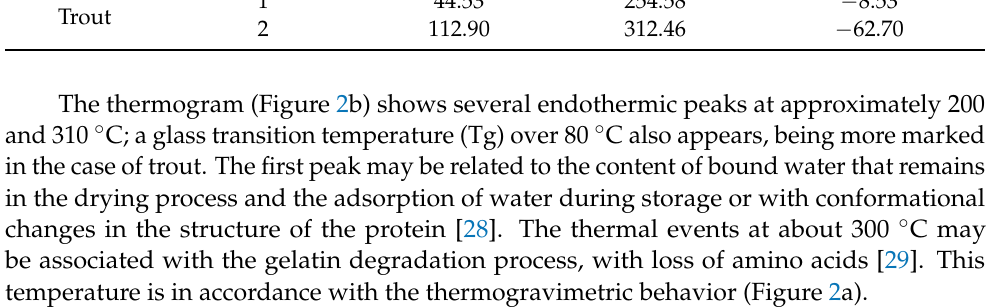
Table 4. Values obtained from TGA and DTGA analysis of seabass, seabream and trout. Onset tem ‐ peratures, T onset ; maximum temperatures, T max ; and Weight loss (%) at 5 °C/min.